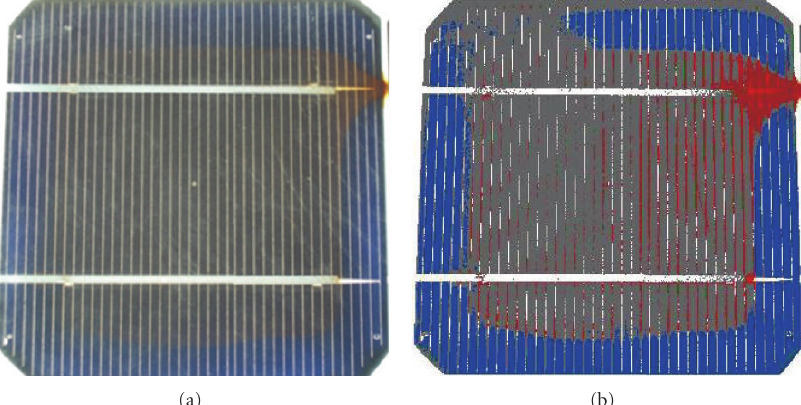
Figure 13: (a) Original digital image of a c-Si SIEMENS M55 cell, (b) respective pseudocolour image provided by the proposed segmentation